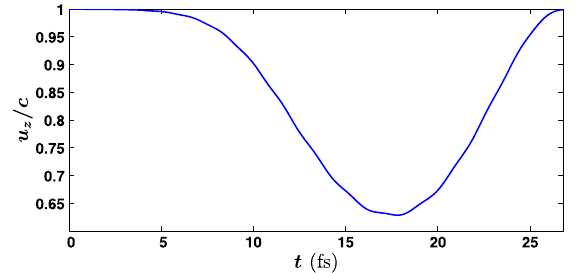
FIG. 13. Longitudinal velocity u z =c plotted vs time t for a sinusoidal-envelope circularly polarized laser pulse with param- eters given in Fig.